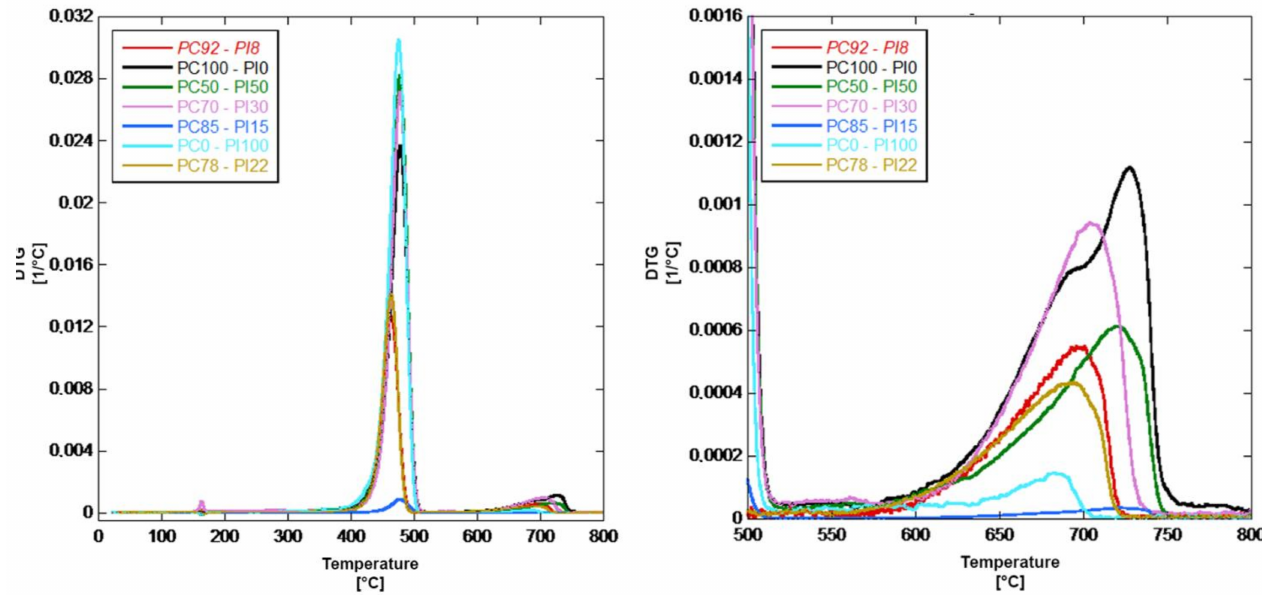
Figure 7. Weight loss rate versus temperature for all blends ( left ), with a detail for high temperatures ( right